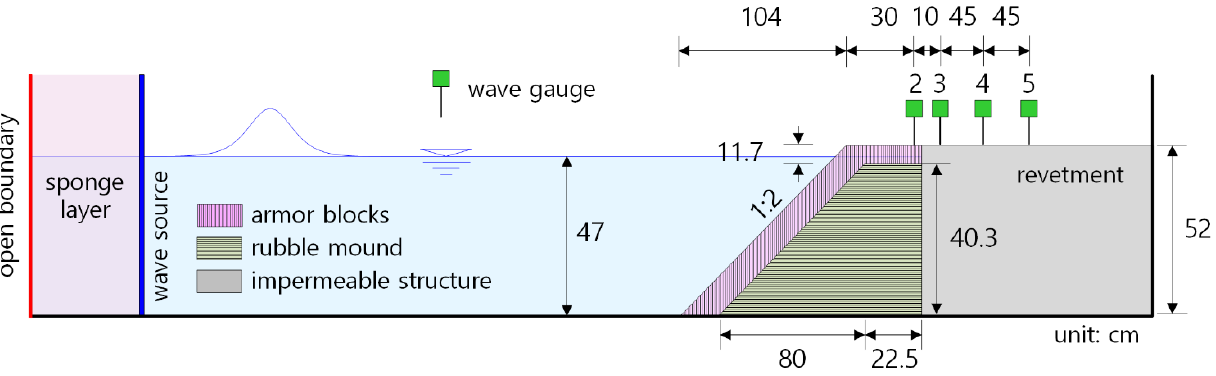
Figure 8. Conceptual diagram of a numerical wave tank including the revetment.